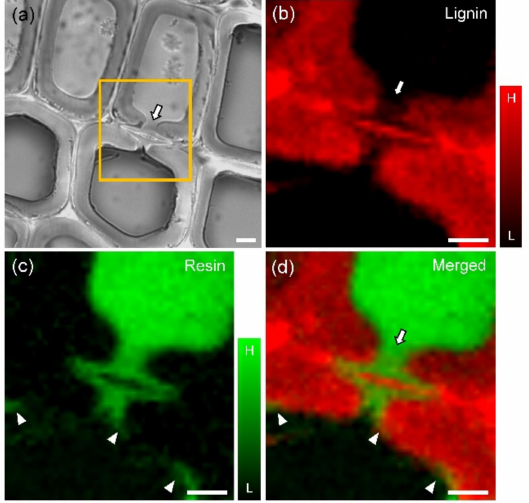
Figure 3. Raman mapping on the cross-section of coated wood subsurface layer at approximately 50–100 µ m deep. Bright-field image shows the area selected for mapping (orange rectangle) ( a ). Raman images were calculated by integrating the Raman bands from 1132 to 1139 cm − 1 ( b , lignin) and from 1721 to 1734 cm − 1 ( c , alkyd resin). Merged image is an overlay of the distribution of lignin and alkyd resin ( d ). Arrow: bordered pit, arrowhead: alkyd resin deposited on the internal surface of the cell lumen. Scale bars: 5 µ